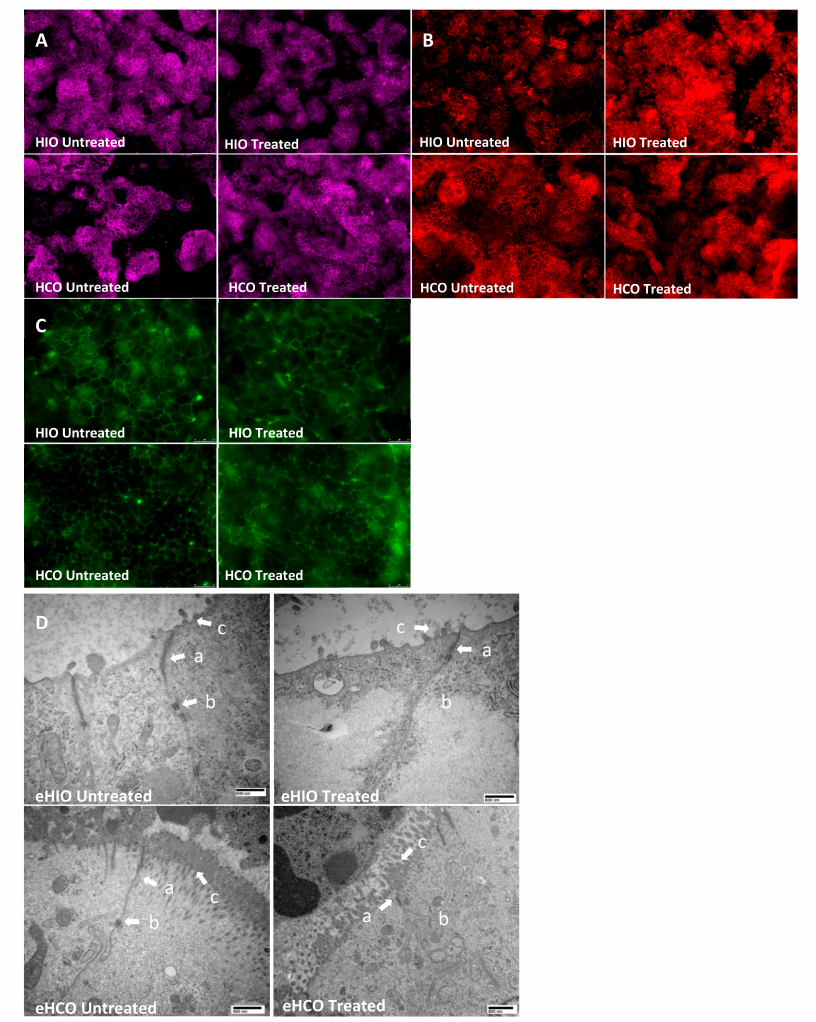
Figure 4. Representative immunofluorescence images of ( A ) JAM-A, ( B ) E-cadherin, and ( C ) ZO-1 in untreated or treated (10 ng / mL TNF α and IFN γ ) in HIO- and HCO-derived epithelium grown on Transwell inserts (A and B; 20 × and C; 40 × magnification. ( D ) Representative transmission electron microscopy images indicate TJ (a) and AJ (b) bundles and microvilli (c) untreated or treated (10 ng / mL TNF α and IFN γ ) in eHIO and